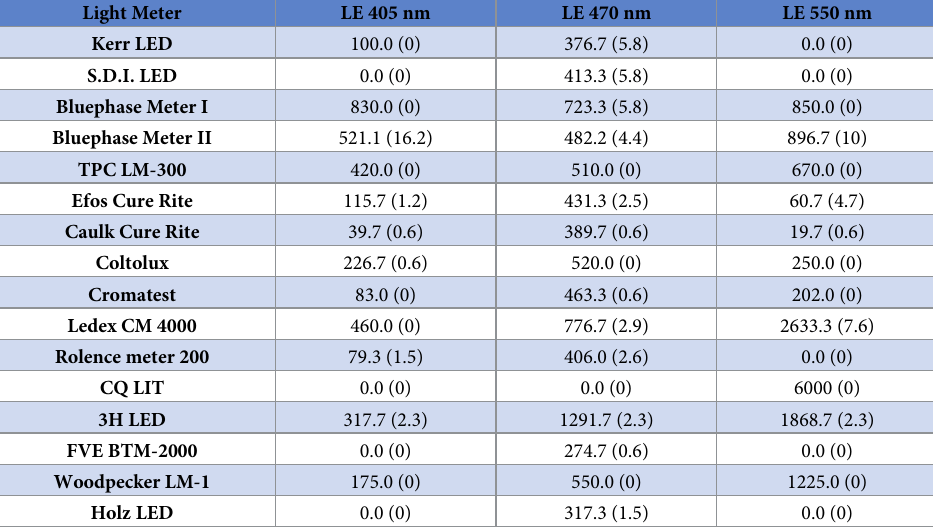
Table 4. Mean irradiance readings (n = 3) for the radiometers generated using the Lumencor Light Engine (LE) with irradiance set at 1049 ± 146 mW/cm 2 for the separate violet ( λ max = 405nm), blue ( λ max = 470nm) and green light ( λ max = 550nm) outputs three